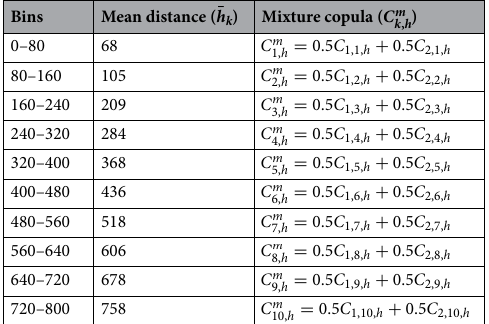
Table 4. The mixture copulas of each bin with w 1 = w 2